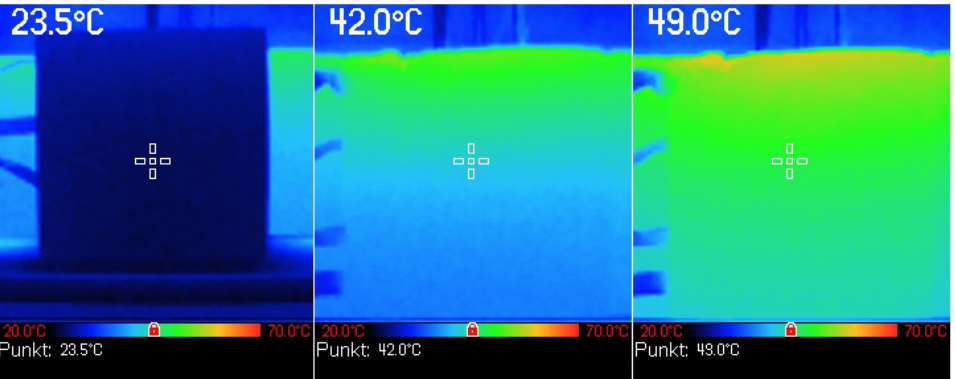
Figure 6. Illustration of the heat flow direction, based on the study of one of the side walls of a sample heated in the test bench using a thermal imaging